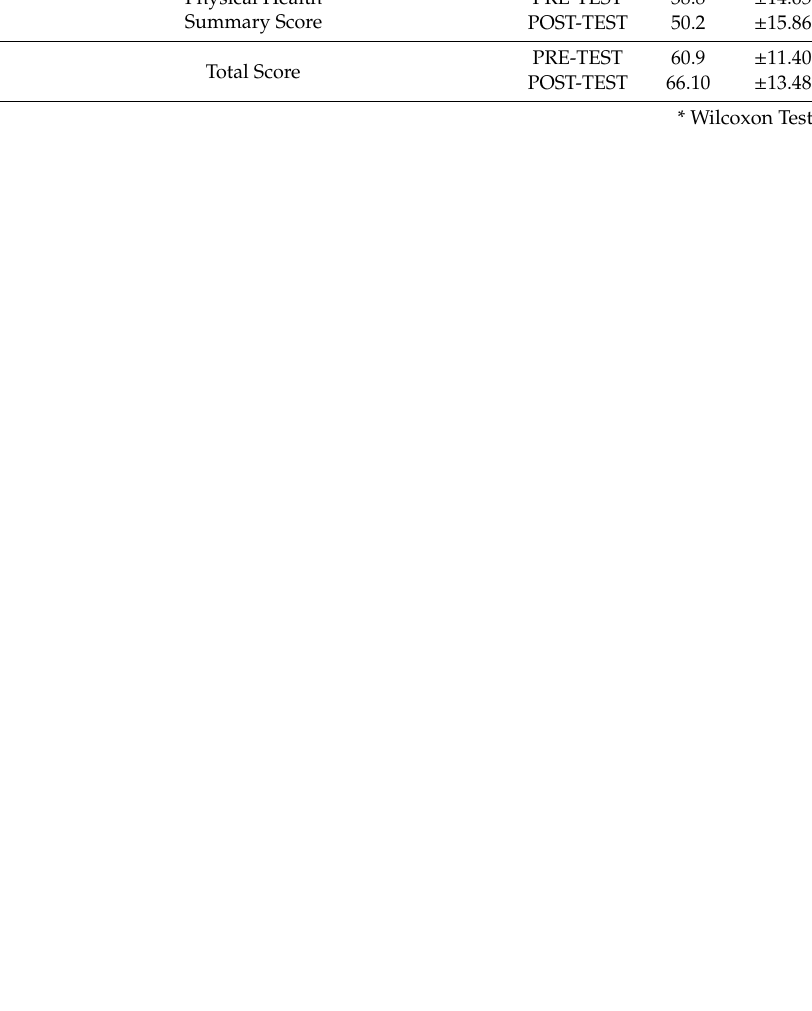
Table 5. Quality of life scoring measured before and after the therapy cycle (PedsQL questionnaire for the various age groups). Lokomat Mixed Traditional Score Mean SD p -Value * Mean SD p -Value * Mean SD p -Value * Psychological Health Summary Score (Emotional, Social and School Functioning Scale